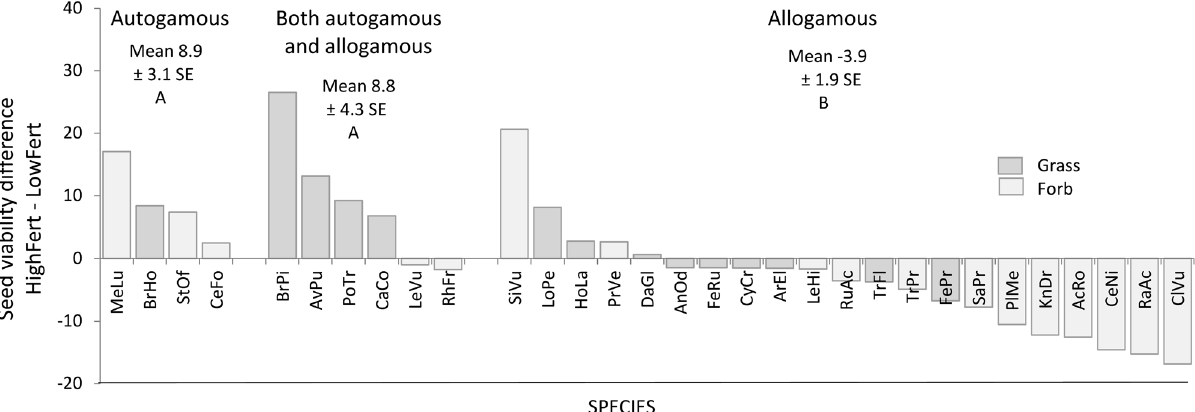
Figure 4. Relationships between variation of viability at higher compared to lower fertilisation level and breeding system of thirty-one grassland species. Data from a fertilisation trial in a semi-natural grassland of the Italian eastern Alps. Species codes in Table 1. Means with different capital letter differ at p < 0.01 according to the Tukey’s